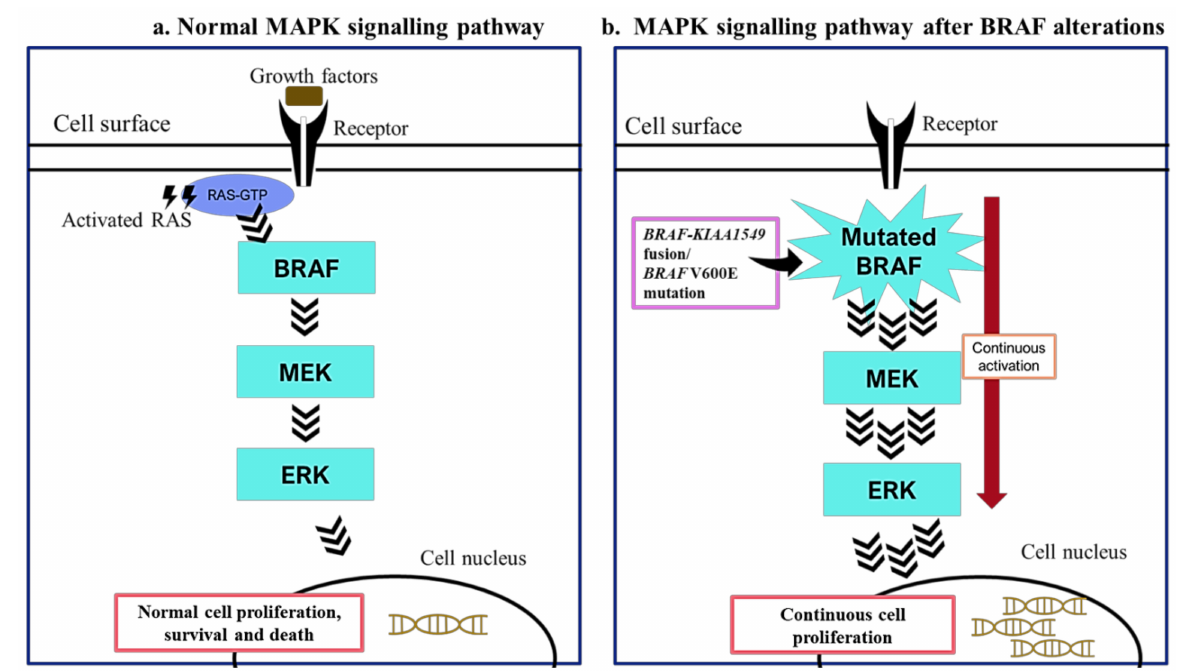
Figure 1. MAPK signalling pathway with and without BRAF alterations. In the normal MAPK signalling pathway ( a ) BRAF interacts with RAS, and the complex activates subsequent proteins in the pathway to promote normal cell proliferation. However, when the BRAF is mutated ( b ) it causes a continuous activation of MAPK pathway, which results in uncontrolled cell proliferation, leading to